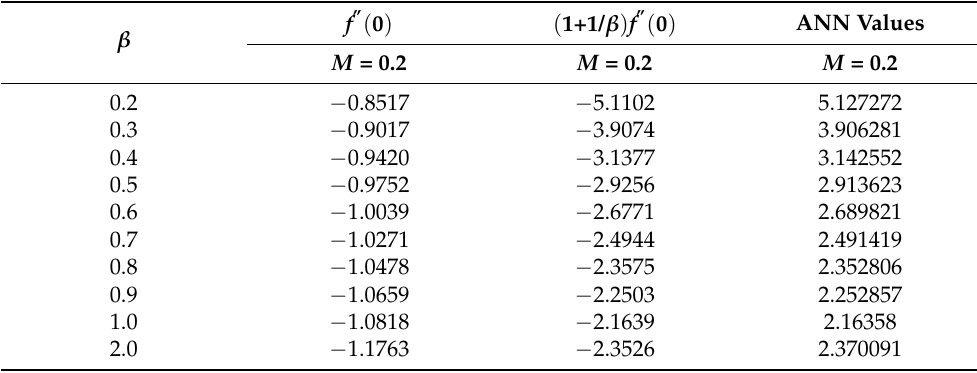
Table 2. Impact of the Casson fluid parameter on the SFC for the magnetic flow